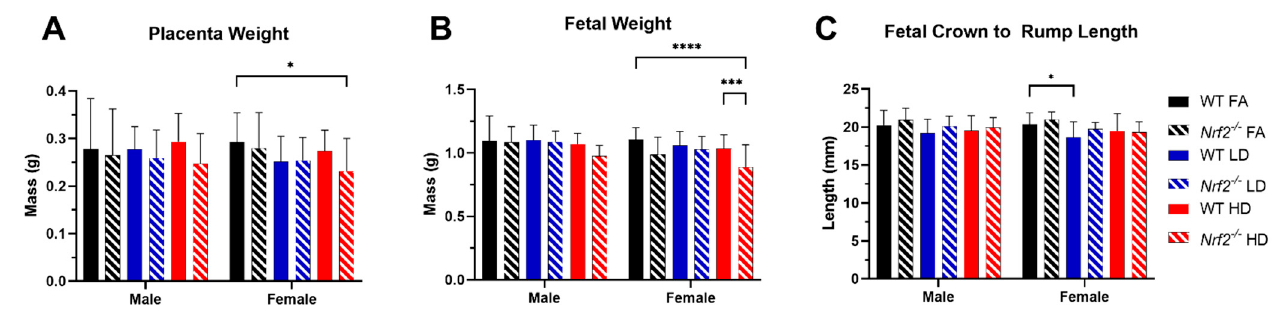
Figure 1. Phenotypic effects of UFPs. ( A ) Average placental weights at GD 18.5 show a significant decrease in the Nrf2 − / − HD female group compared with WT FA control female group. ( B ) Fetal weights at GD 18.5 averaged by sex demonstrates a significant decrease in Nrf2 − / − HD compared with WT HD and WT FA in females. ( C ) Average crown to rump lengths at GD 18.5 show a decrease in the LD versus FA control for WT females. Offspring sample sizes include WT FA male ( n = 13), WT LD male ( n = 22), WT HD male ( n = 20), WT FA female ( n = 18), WT LD female ( n = 25), WT HD female ( n = 24), Nrf2 − / − FA male ( n = 13), Nrf2 − / − LD male ( n = 16), Nrf2 − / − HD male ( n = 23), Nrf2 − / − FA female ( n = 11), Nrf2 − / − LD female ( n = 12), and Nrf2 − / − HD female ( n = 20). Data analyzed using two-way ANOVA with Tukey’s multiple comparison test (* p < 0.05; *** p < 0.001; **** p < 0.0001).